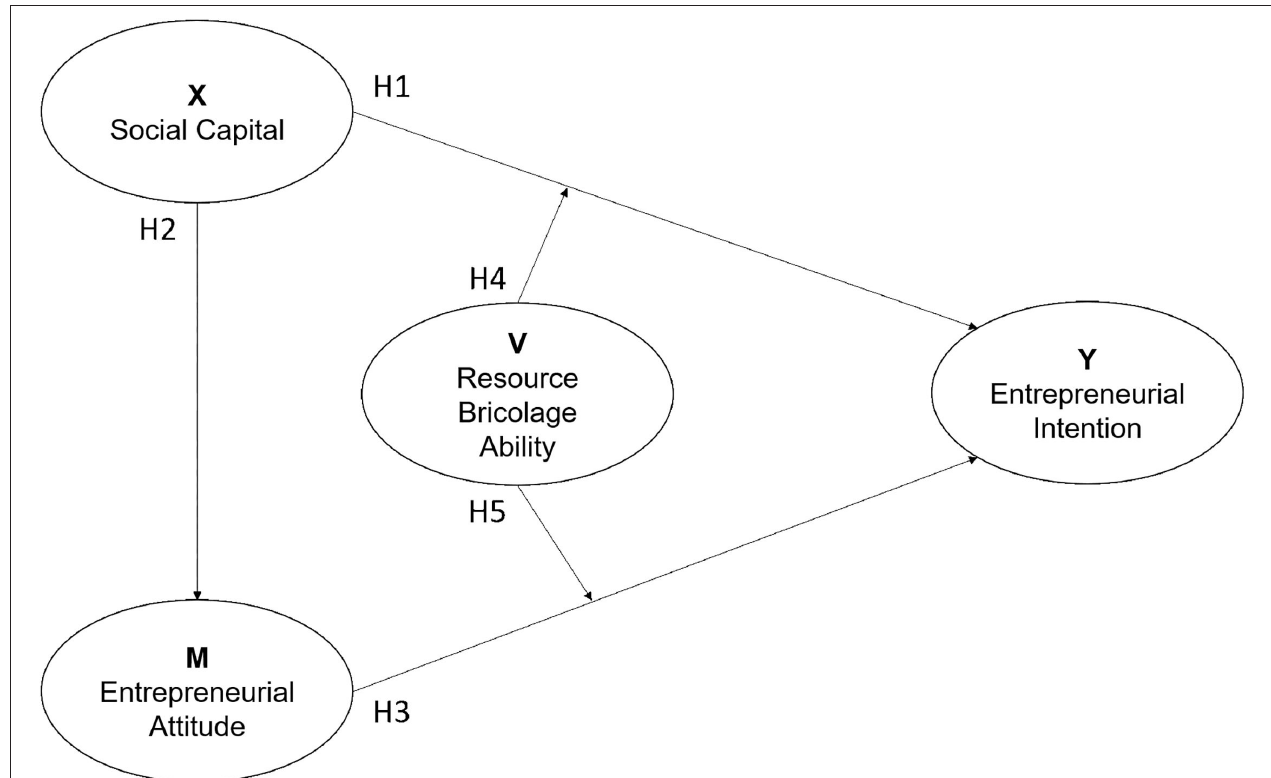
FIGURE 2 | The framework of the